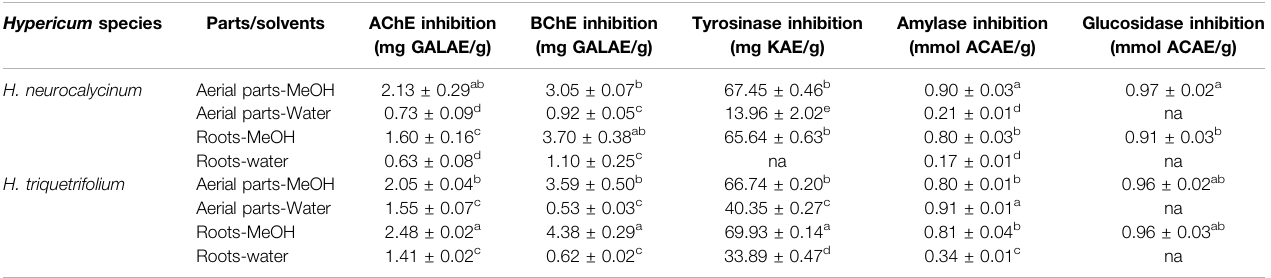
TABLE 4 | In vitro enzyme inhibitory effects of Hypericum triquetrifolium and Hypericum neurocalycinum extracts. Hypericum species